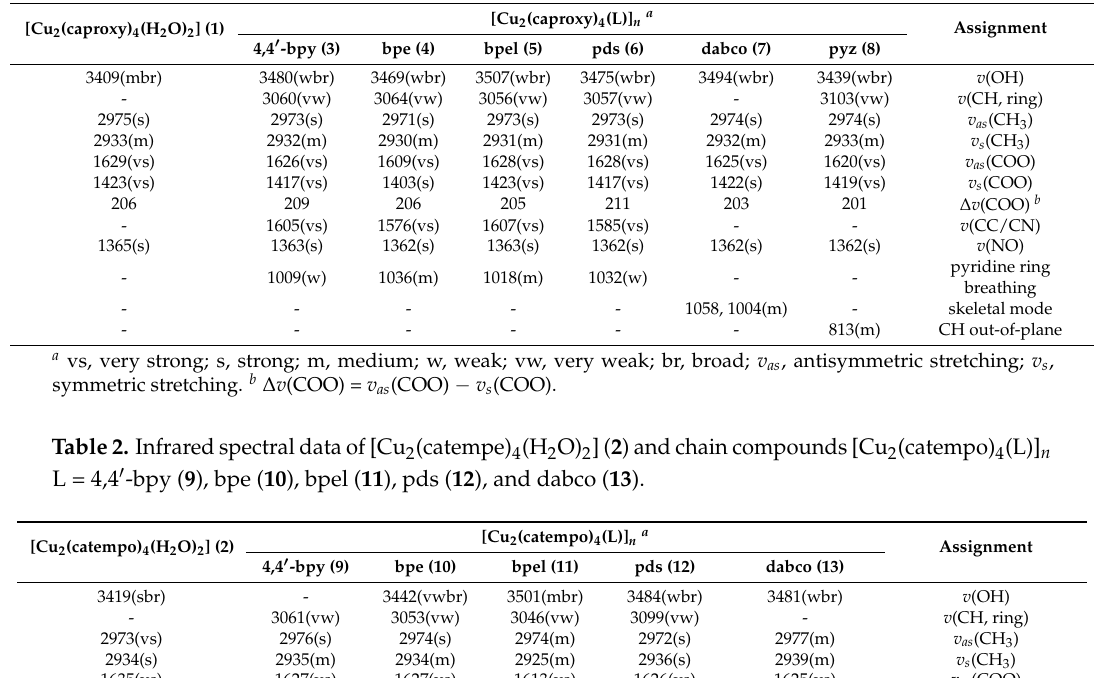
Table 1. Infrared spectral data of [Cu 2 (caproxy) 4 (H 2 O) 2 ] ( 1 ) and chain compounds [Cu 2 (caproxy) 4 (L)] n L = 4,4 (cid:48) -bpy ( 3 ), bpe ( 4 ), bpel ( 5 ), pds ( 6 ), dabco ( 7 ), and pyz ( 8 ).